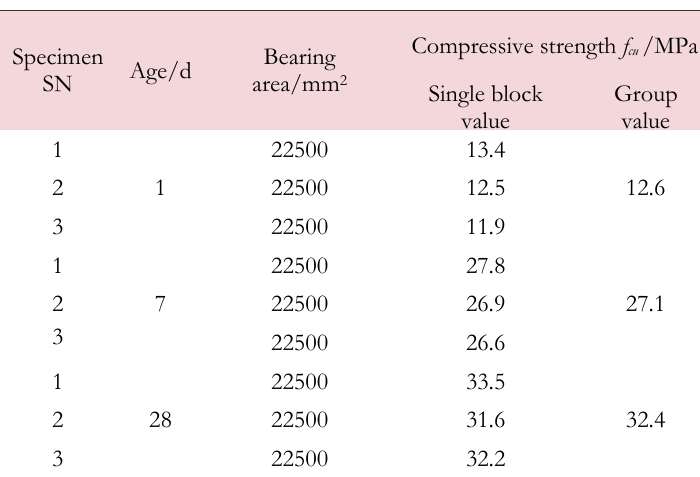
Table 9: Compressive strength of